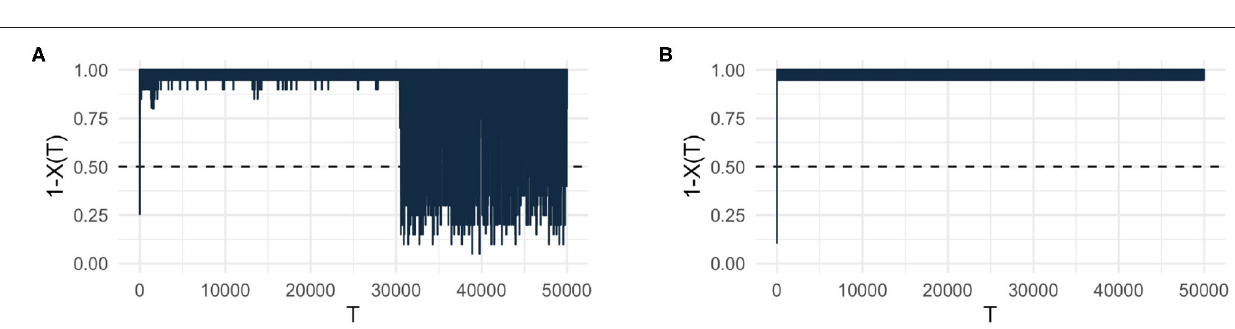
FIGURE 6 | Fraction of firms remaining in the network, 1 node interventions